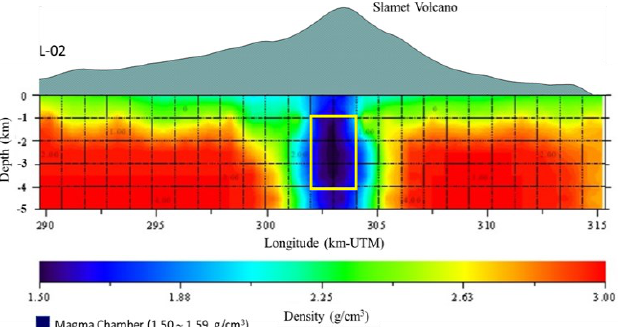
Fig. 11. A cross-section of the anomalous object model along L-02 trajectory at latitude of latitude of 9,198.540 km-UTM